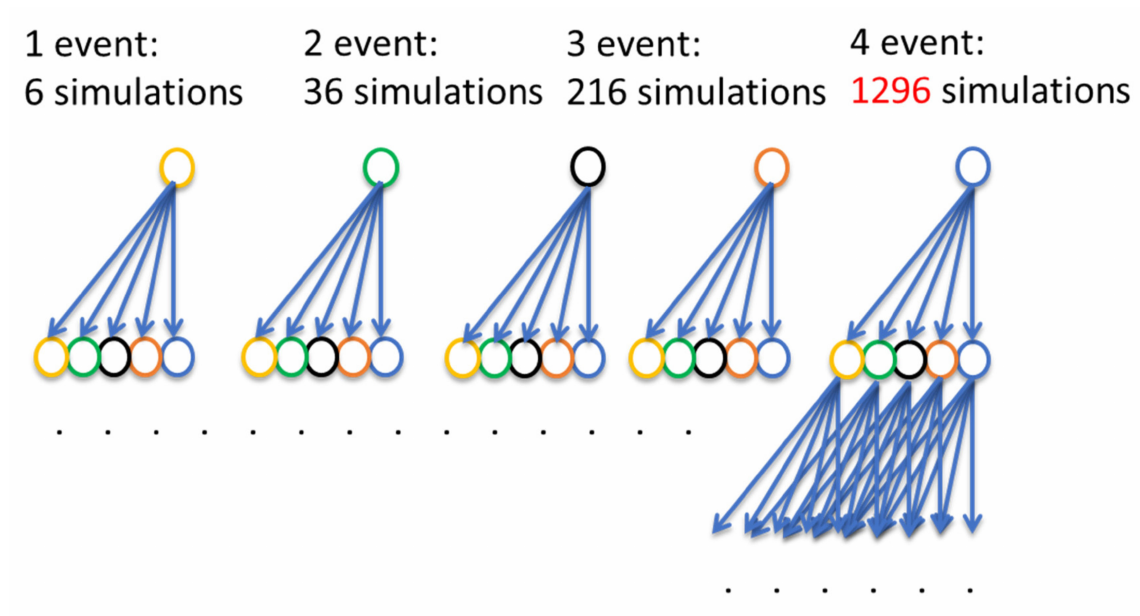
Figure 7. Exponential increase of